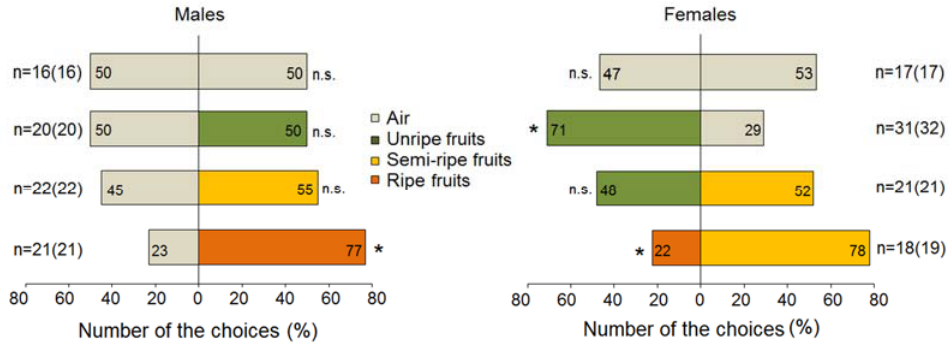
Figure 1. Choices by Rhagoletis batava between the odours of sea buckthorn fruits depending on their ripening stage in Y ‐ tube olfactometer. n, Number of flies that made choice between two arms of Y ‐ tube; a total number of flies tested is given in parentheses; * asterisks indicate statistically significant differences between choices ( p < 0.05); n.s., nonsignificant, χ 2 test.